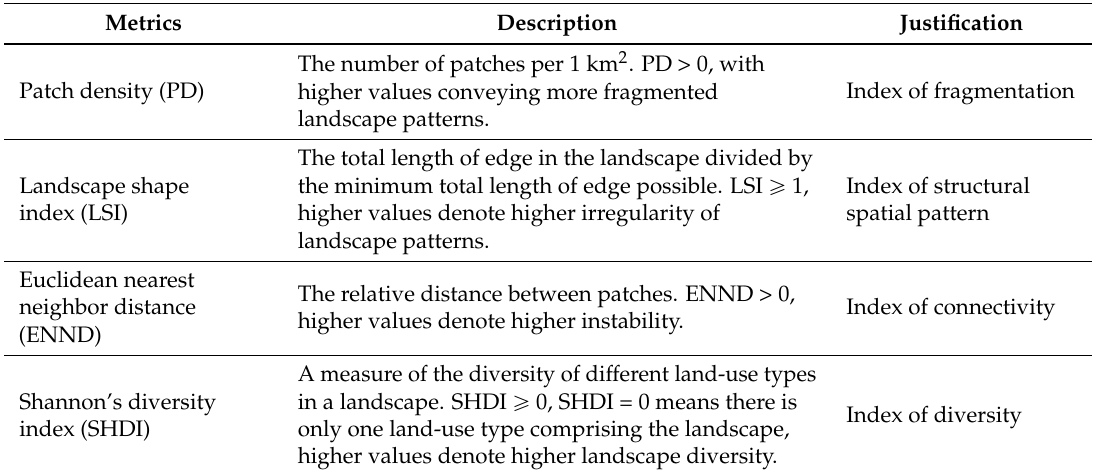
Table 1. Landscape metrics and their ecological characteristics.